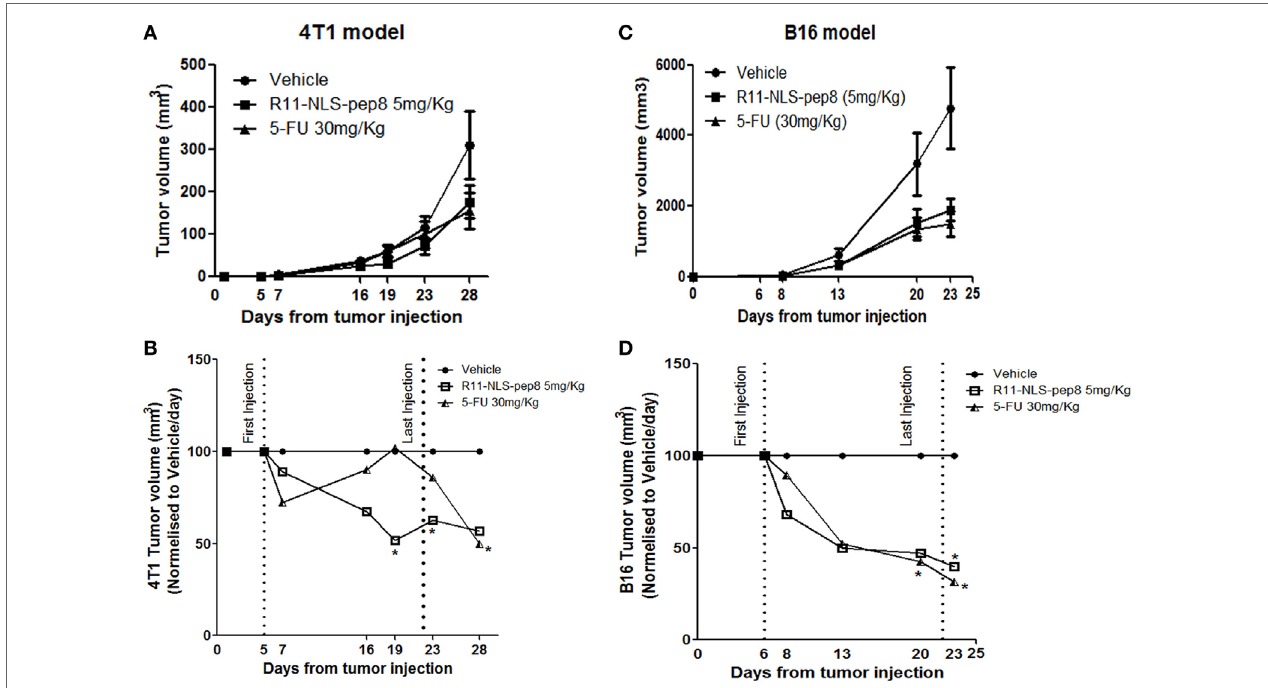
FigUre 5 | Effect of R11-NLS-pep8 on 4T1 and B16 in vivo tumor models. (a) 4T1 cells or (c) B16 cells were injected into the nipple pad or flank of young BALB/C females or C57BL/6 males, respectively (day 0). At day 5, mice were divided to subgroups according to mice weight. Treatment was started at day 5 (4T1) or day 6 (B16) and end at day 22. Treatment was administrated every 2 days three times per week; 5-FU was administered intraperitoneally (IP) while R11-NLS-pep8 was administrated intravenously (4T1) or IP (B16). Tumor volume (mm 3 ) was measured at days as indicated on graphs mean tumor volume (mm 3 ), (B) 4T1 and (D) B16 were normalized to vehicle/day to show the effect of treatment on tumor volume per day. Statistical analysis was performed on original tumor volume data. Unpaired t -test; one-tail, * p <